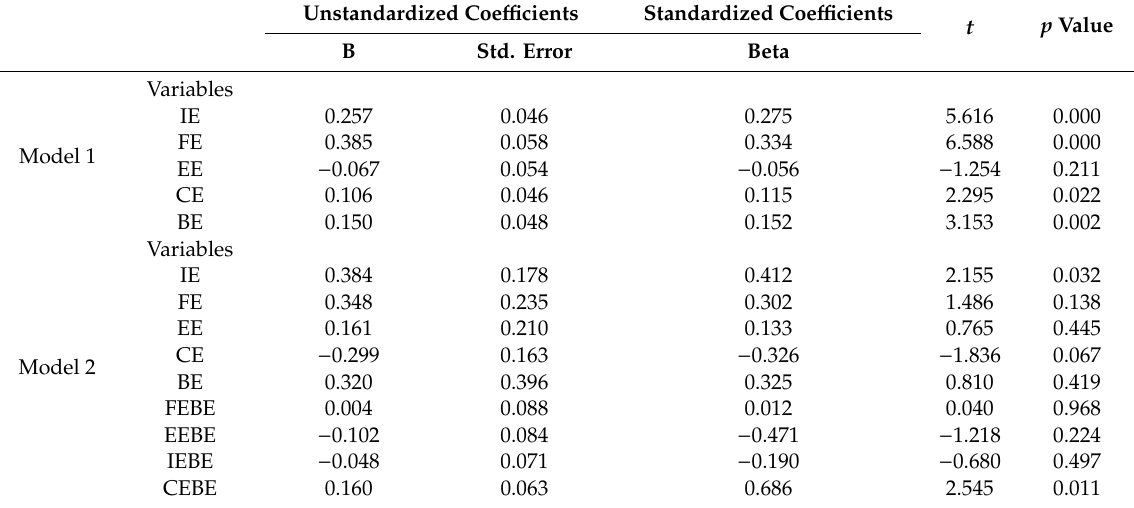
Table 6. Coe ffi cients of regression and